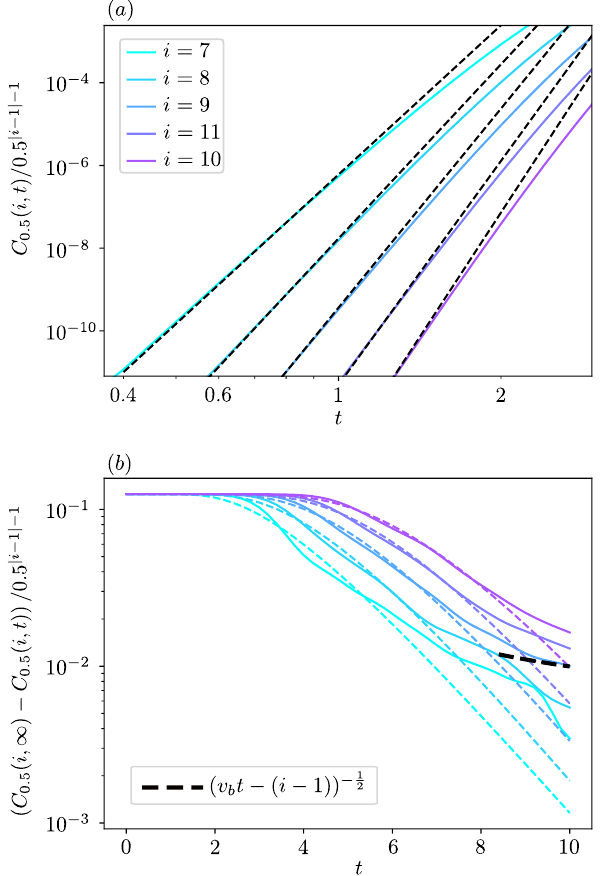
Figure 8: (a) Rescaled α -OTOC growth ( L = 12) for fixed distance i at early times, fit- ted by a power-law scaling Eq. (12) (dashed lines). (b) Time evolution of the rescaled α -OTOC at intermediate times. The dashed lines indicate predictions for random uni- tary circuits Eq. (13). At long times one expects hydrodynamic tails due to charge conservation [ 66 ] , indicated by a black dashed